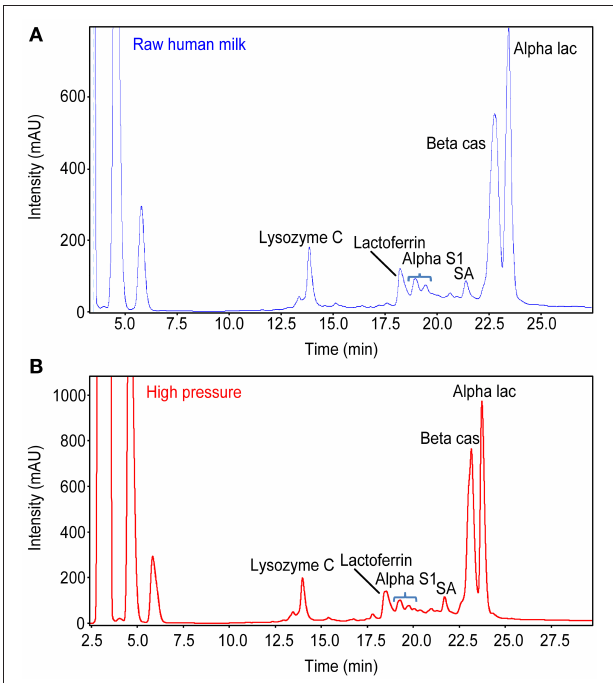
FIGURE 1 | Comparison of proteins profile between (A) Raw Human Milk and (B) HHP Human Milk. There is strictly the same proteins profile of Raw HM and HHP HM.